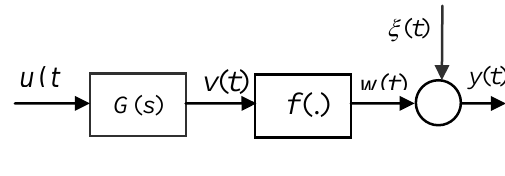
Fig. 1. Nonlinear system structured by Wiener